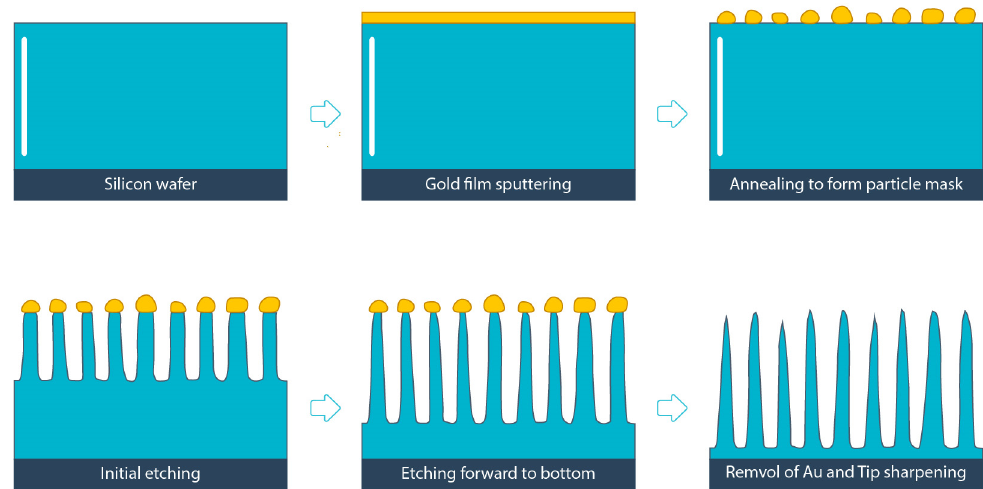
Figure 1. The schematic diagram of the nanowire fabrication process. The gold thin film is deposited on the P-type silicon wafer. Thermal annealing is employed to create gold particle mask. The followed etching treatment consists of initial Bosch etching, forward etching for more undercut, and the continue etching to remove Au nanoparticles.